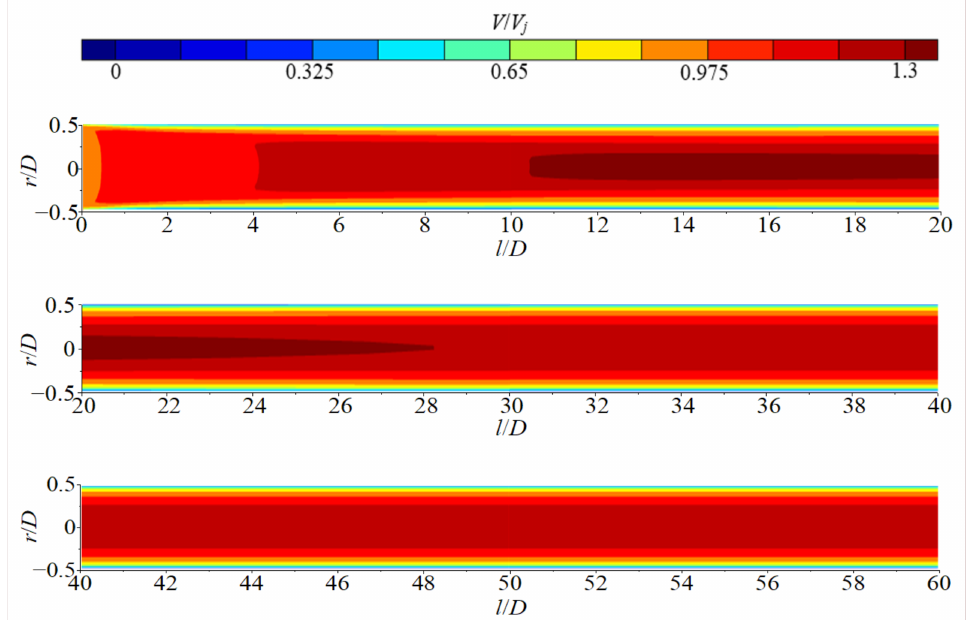
Figure 5. Dimensionless velocity V/V j distribution nephogram in the cross-section of a circular